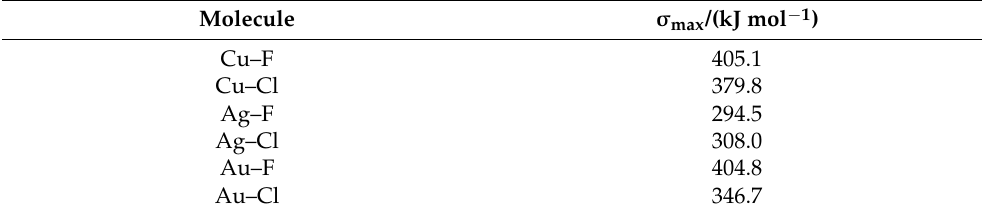
Table 5. The maximum positive molecular electrostatic surface potentials ( σ max ) for the diatomic molecules M–X (M = Cu, Ag, Au; X = F, Cl) at the 0.001 e /bohr 3 iso-surface. These were calculated at the MP2/aug-cc-pVTZ level of theory and occur on the molecular axis near to the metal atom